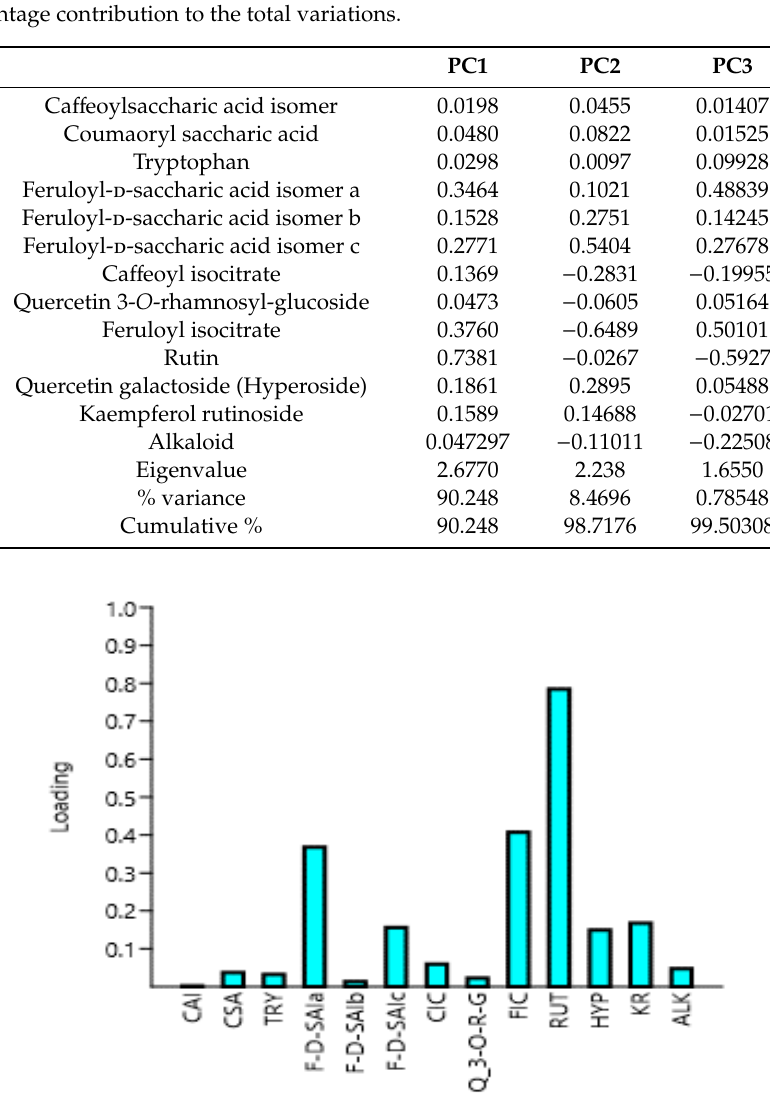
Figure 4. The loadings plot of the phenolic compounds and their percentage contribution to the total variations in the amaranth plant. CAI, caffeoylsaccharic acid isomer; CSA, coumaoryl saccharic acid; TRY, tryptophan; F- d -SAIa, feruloyl- d -saccharic acid isomer a; F- d -SAIb, feruloyl- d